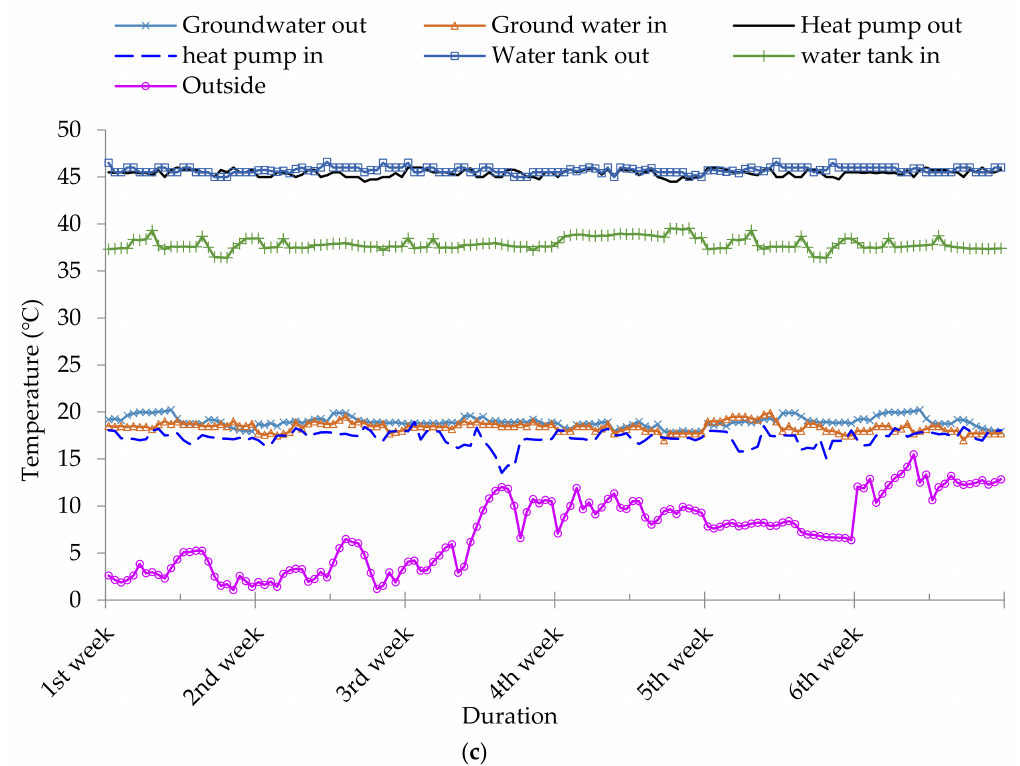
Figure 5. The inflow and outflow water temperature of three pumps of the geothermal system. ( a ) Weaning period; ( b ) growing period; ( c ) finishing period.